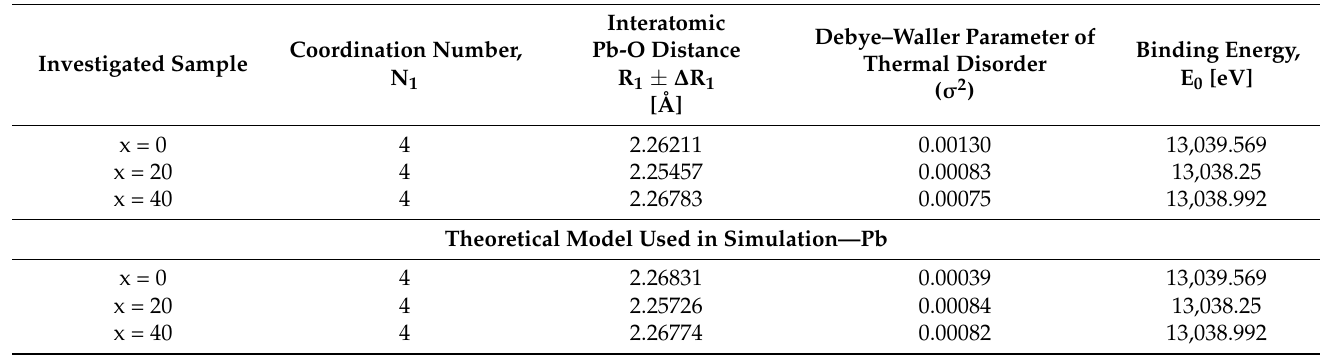
Table 1. Parameters of the global structure for the lead atom in the first coordination sphere for the vitroceramics in the system with chemical formula 15MnO 2 · 85[(100 − x)PbO 2 · xPb] with x = 0, 20 and 40 mol%